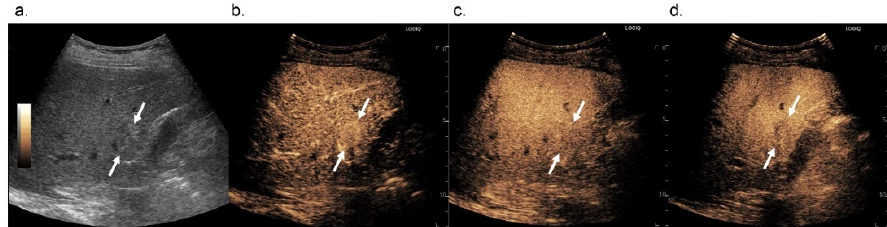
Figure 3. Images in 74-year-old man with pathologically confirmed hepatocellular carcinoma in segment 5 of the liver. On B-mode US, a 1.7-cm hyperechoic nodule is observed ( a , arrows). On Sonazoid-enhanced US, the nodule shows arterial phase hyperenhancement ( b , arrows) and does not show washout until 5 min after contrast media injection ( c , arrows). The nodule shows hypoenhancement in the Kupffer phase ( d , arrows).